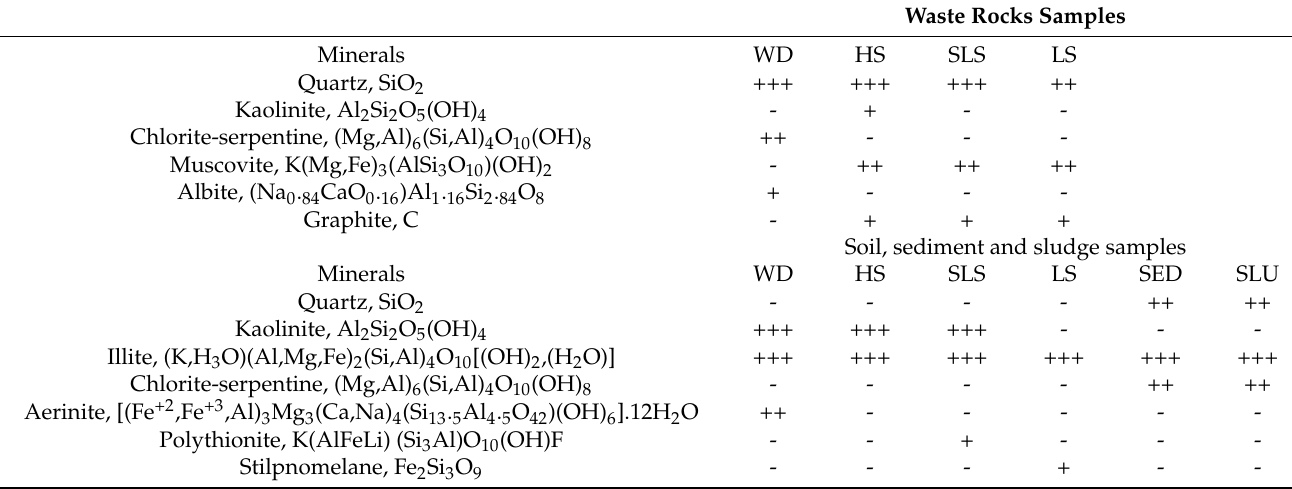
Table 3. Summary of mineral composition of the waste rock, soil, sediment and sludge of gold mine waste.